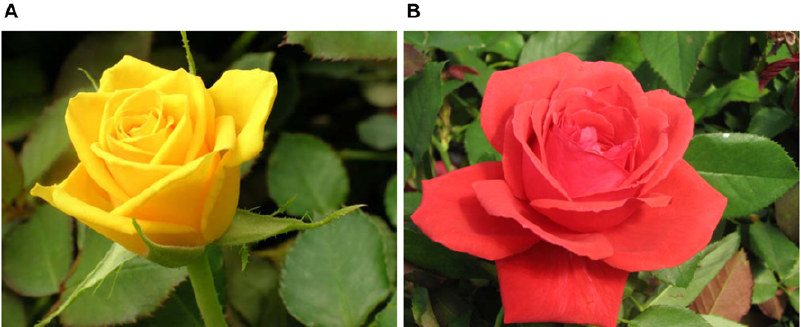
Figure 1. The Rosahybrida L. cultivars used as parents of the segregating population (GGFC). A . Rosa hybrida cv. Golden Gate (GG) is a modern cut-flower cultivar, containing carotenoids that are responsible for its yellow color, with only faint odor and long vase life. B . Rosa hybrida cv. Fragrant Cloud (FC) is an old garden cultivar with large fragrant flowers, short vase life and peach red petals color due to the presence of anthocyanins (Short movie presenting the vase life behavior of these cultivars is available at http://www.youtube.com/watch?v=odOp92TK5Xg - the movie composed of pictures that were taken every 60 minutes with total time lapse of 15 days).